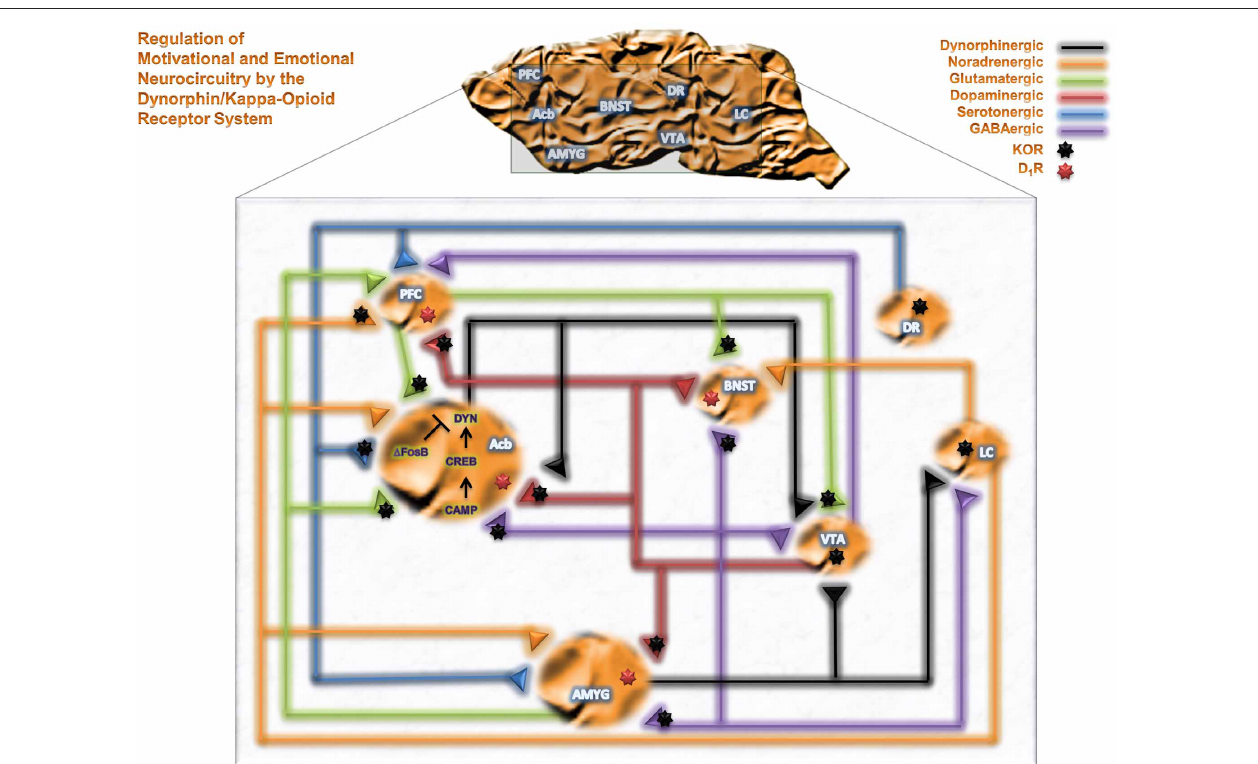
FIGURE 1 | The DYN/KOR system in motivational and emotional neurocircuitry. A schematic representation of brain motivational and emotional neurocircuitry, illustrating relevant neurotransmitters implicated in the pathophysiology of various neuropsychiatric disorders following chronic exposure of alcohol and drugs of abuse. Abbreviations: PFC, prefrontal